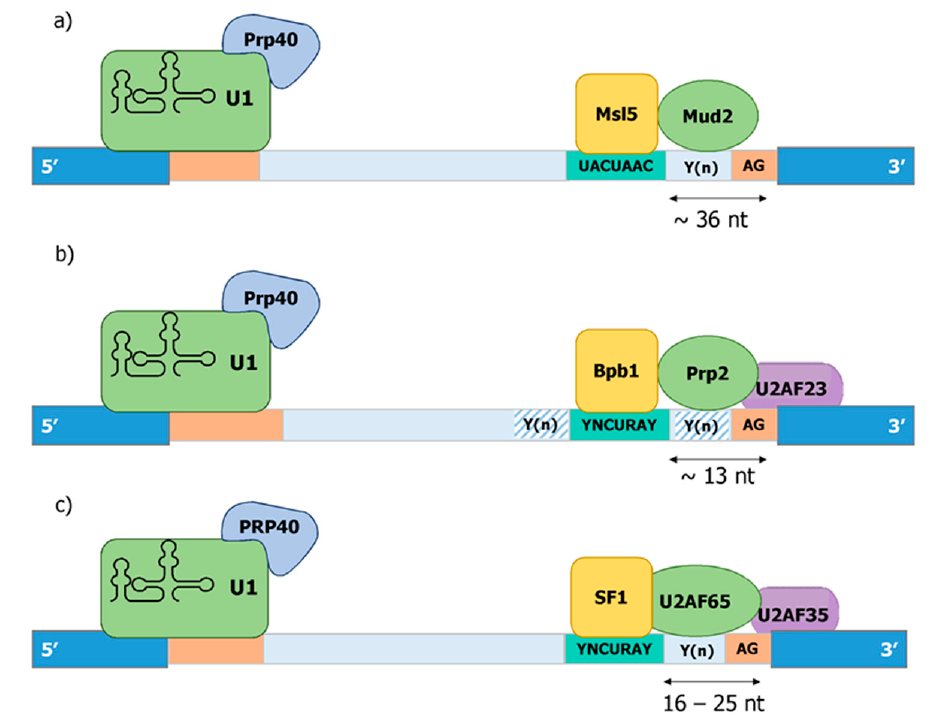
Figure 4. The E-complex in S. cerevisae , S. pombe , and human. Cis- and trans-elements within the exon and intron in ( a ) budding yeast, ( b ) fission yeast, and ( c ) humans. Distance between BP and AG dinucleotide is represented by